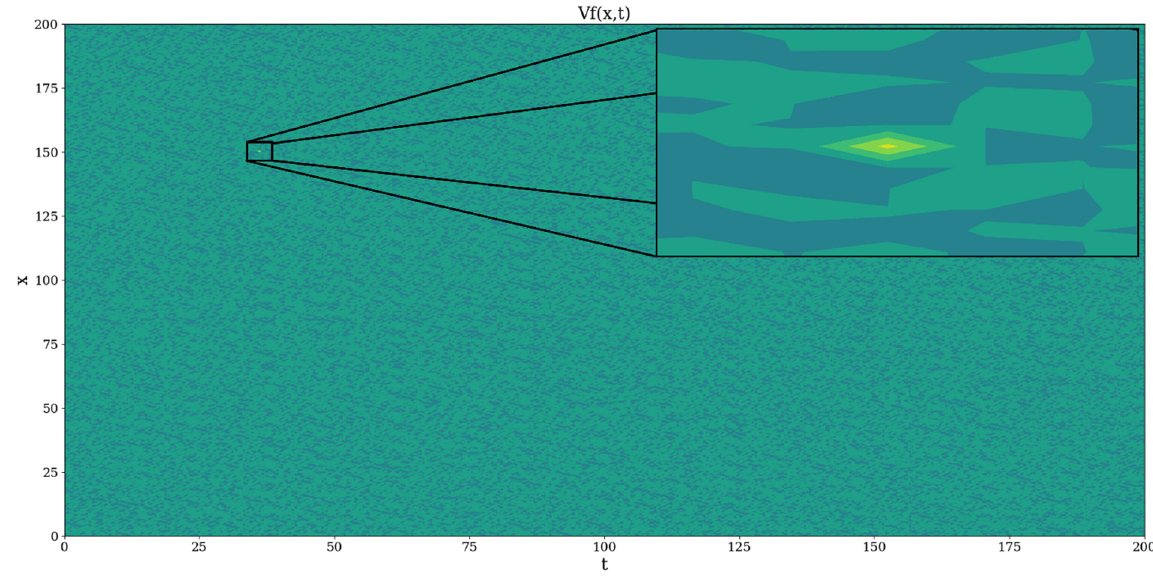
Figure 1. Atmospheric multifractal non-differentiable velocity V F ( x,t ) plot in multifractal non-dimensional coordinates, Ω = 0.5 ; zoom: peak produced by spontaneous symmetry break.